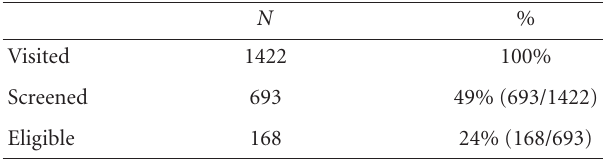
Table 1: Number of mothers visited, screened, and